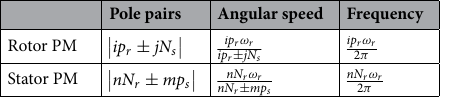
Pole pairs Angular speed